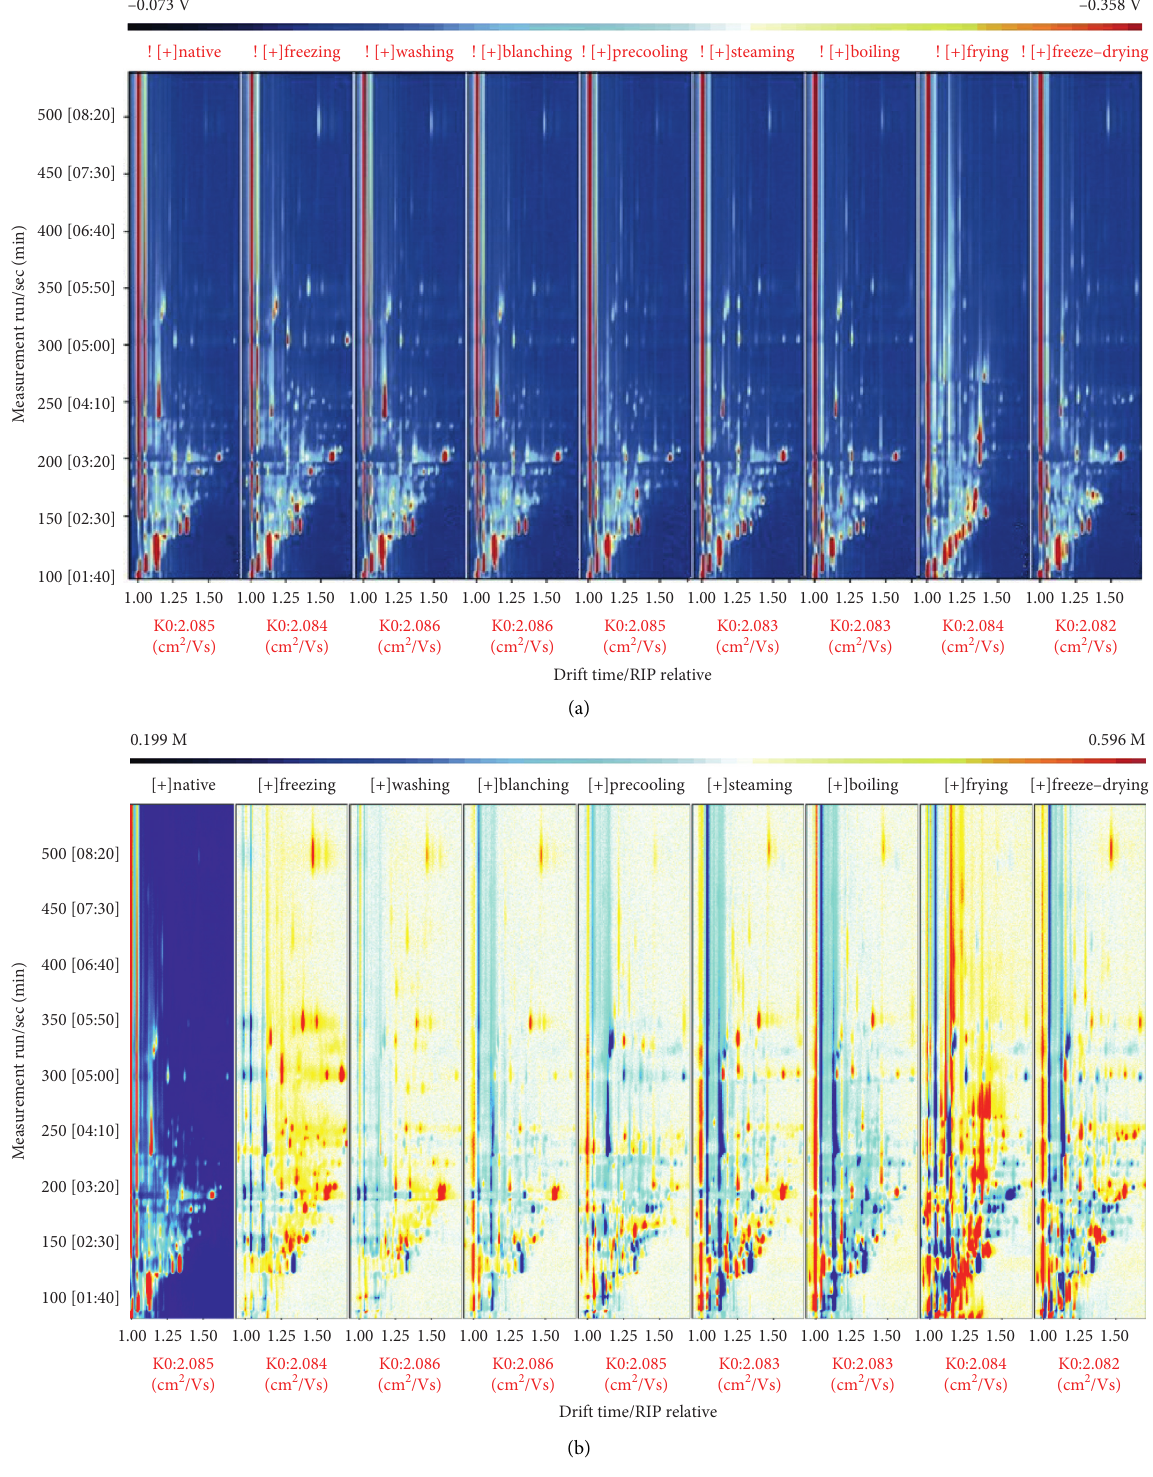
Figure 1: GC-IMS topographic plots of peas samples: (a) 2D-topographic plot and (b) differentiation plot of volatile